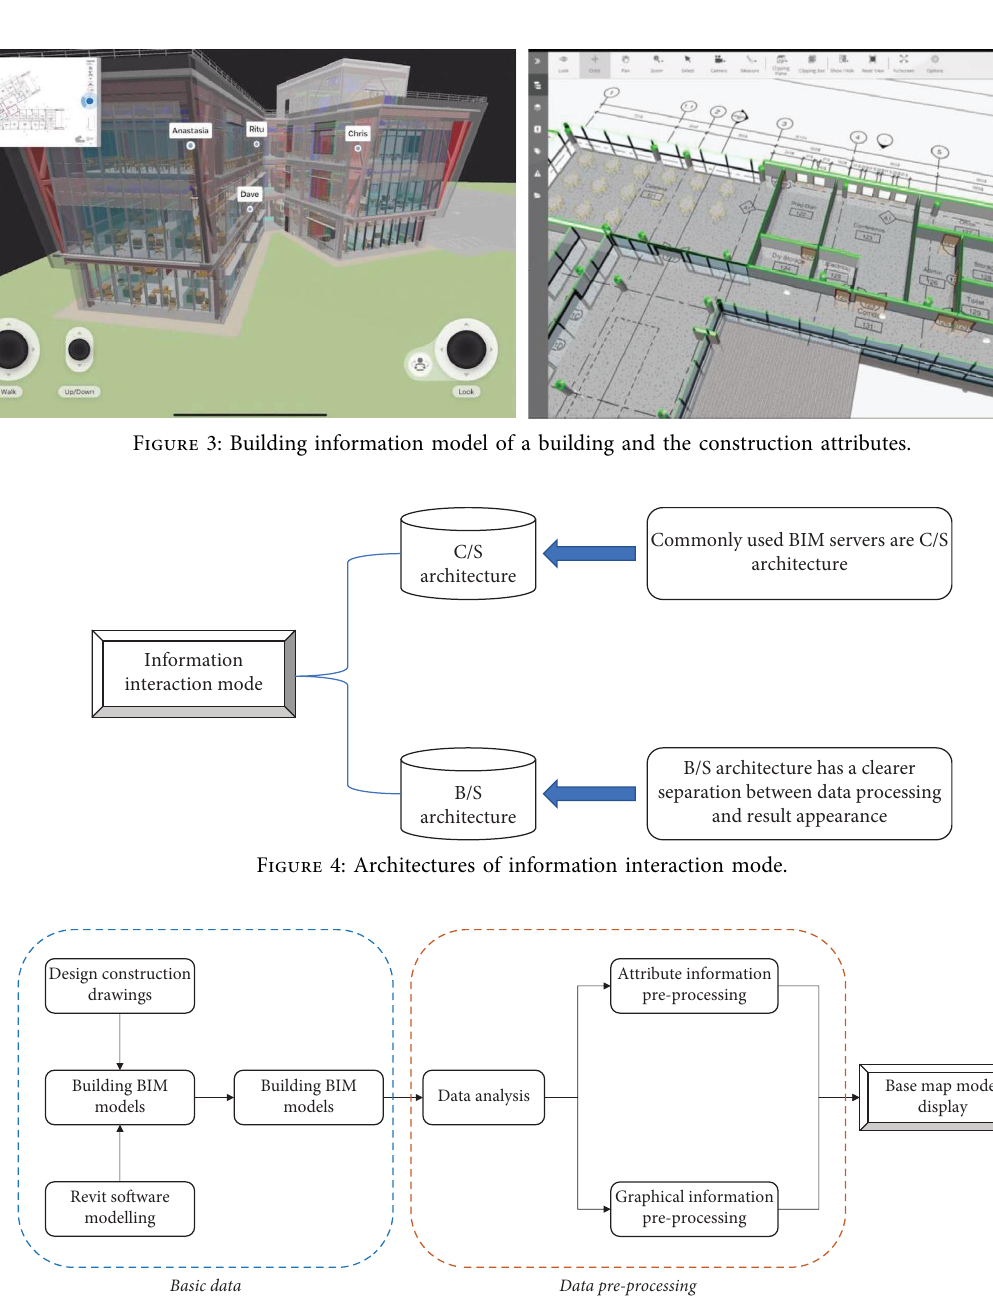
Figure 5: Road network model BIM data preprocessing process.